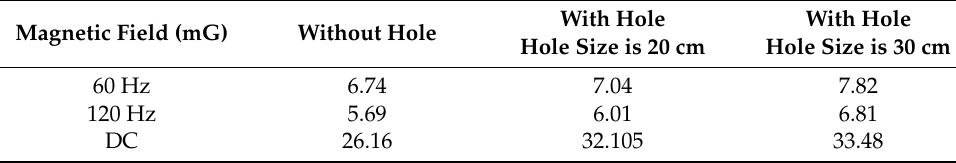
Table 7. Comparison between reducing ratio in different hole patterns.